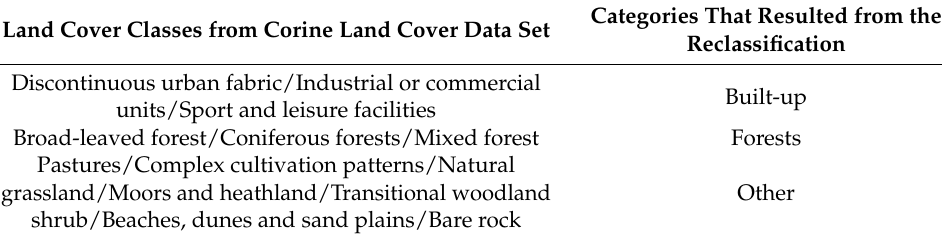
Categories That Resulted from